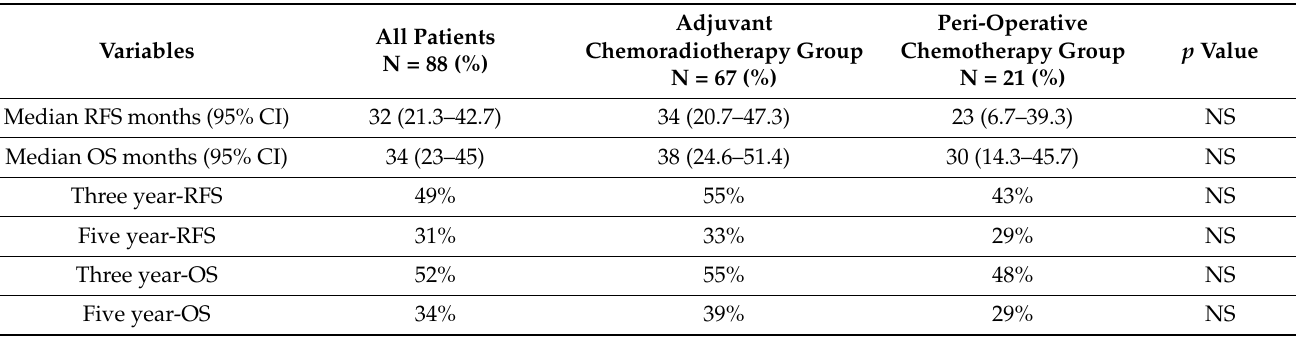
Table 2. Outcome of patients with early stage stomach and GE junction cancers who received adjuvant chemoradiotherapy versus perioperative